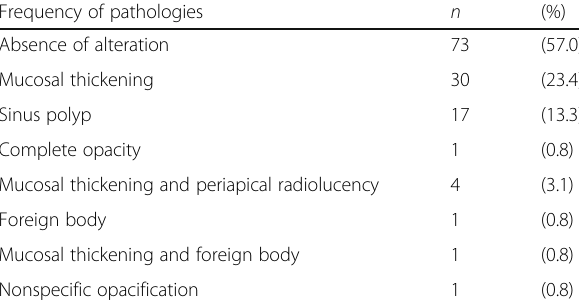
Table 2 Frequency of pathologies in 128 maxillary sinuses Frequency of pathologies